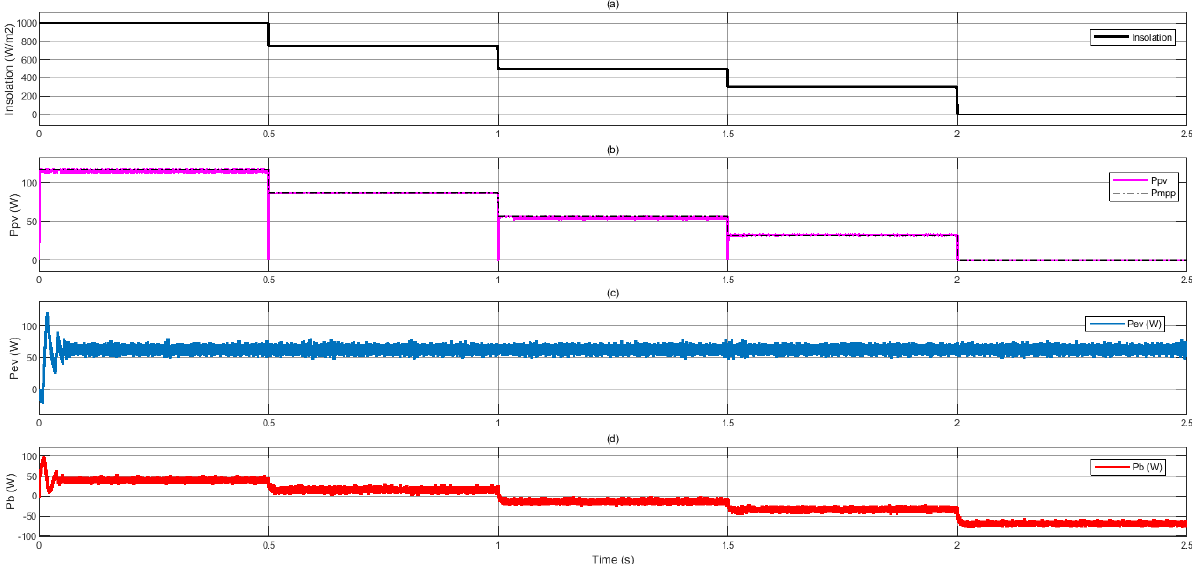
Figure 7. The system response with the fuzzy controller: ( a ) the sun insolation level, ( b ) the PV power, ( c ) the EV battery power, and ( d ) the ESS battery power.